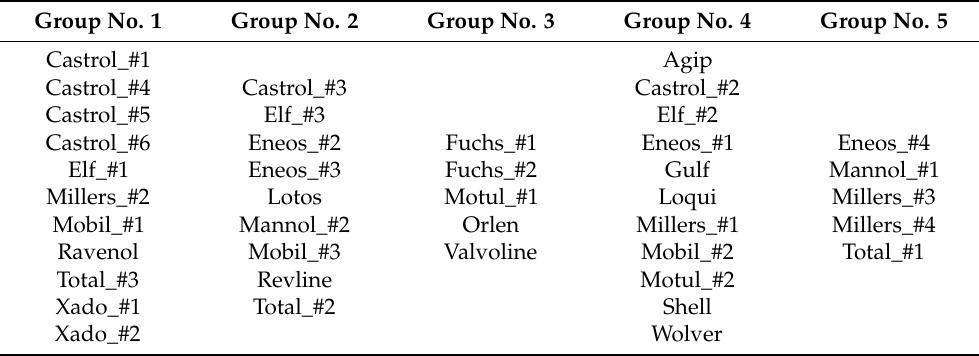
Table 5. Assignment of the oils into the different groupings according to similarity in Q-factor (quality factor)